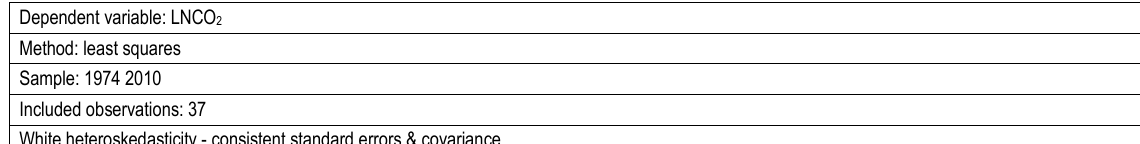
Table 2. Long run